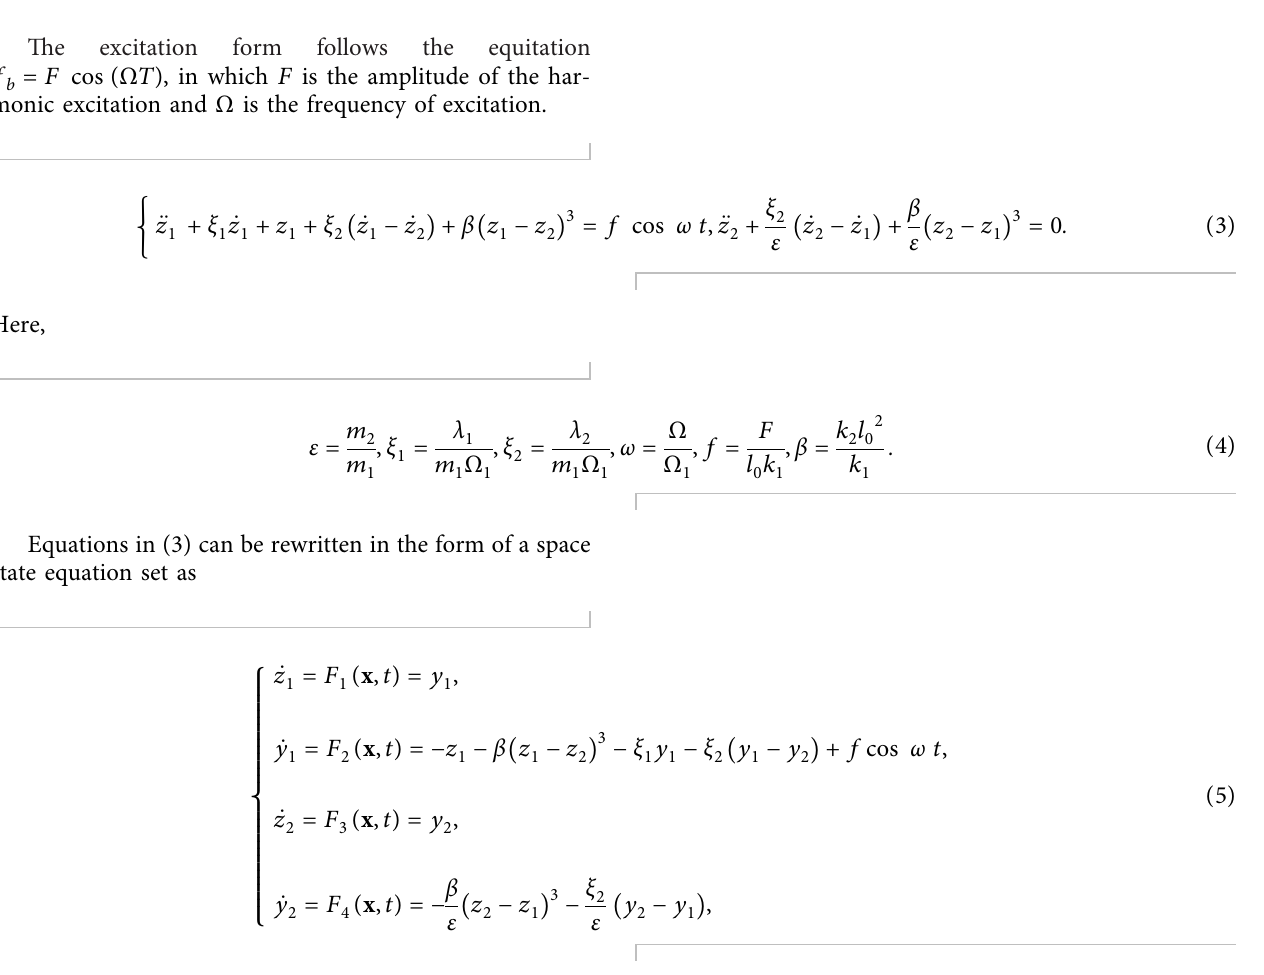
Figure 1: Te dynamics model of the NES vibration absorption